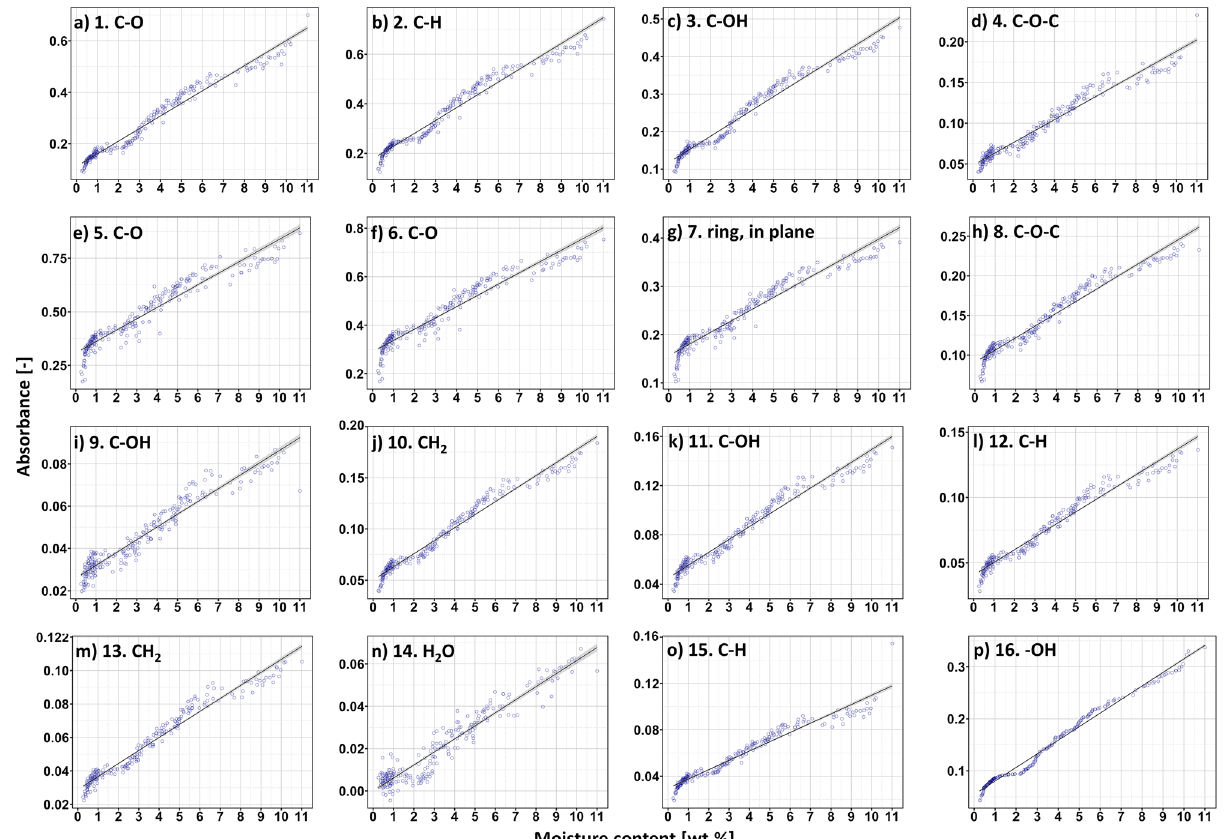
Figure 2. Height of the selected peaks ( a–p ) plotted as a function of moisture content in cellulose fibres determined through Karl-Fischer titration. Experimentally measured band absorbance (dark blue) and mathematically adjusted regression (black) with marked confidence area